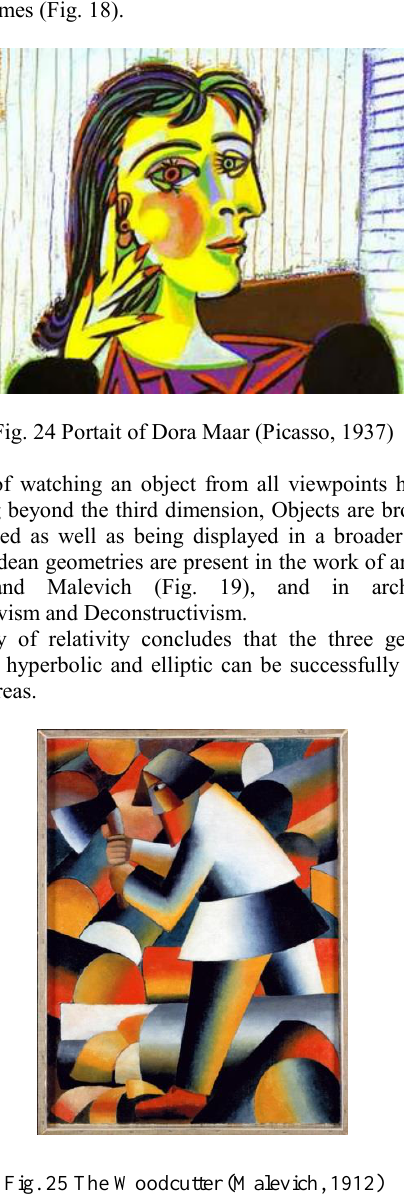
Fig. 26 Casa Milà (Barcelona, 1906-12)